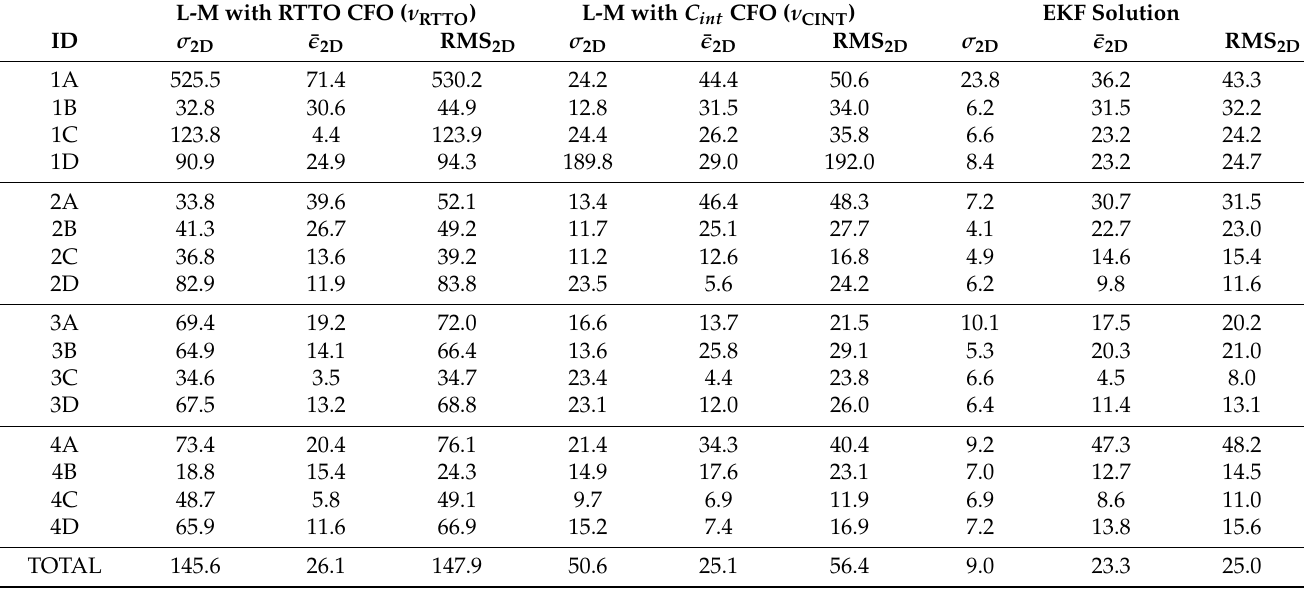
Figure 9. 2D Position estimates obtained using EKF with clock drift tracking. The improvement of 2D solution is less prominent in case of the weighted horizontal standard deviation ( σ w 2D ) and RMS error (WRMS 2D ), see Table 4. In comparison with the 3D solution we observe approximately 42% improvement of σ w 2D and 42% in WRMS 2D . Such results suggest that the 2D solution leads to more stable convergence and reduces the number of outliers. Table 3. Non-weighted statistics of 2D position estimates (all values in